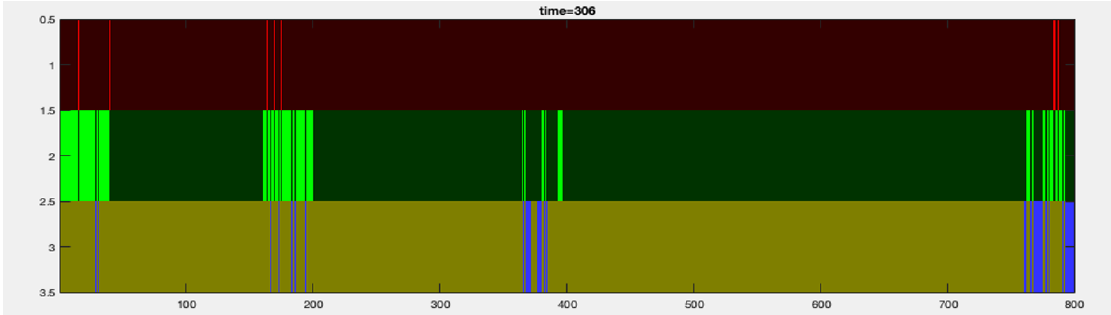
Figure 13. A snapshot of the status of the network. Bottom line denotes susceptible individuals (blue marks infected or recovered or died), middle lines are infected (light green marks), top line represents deaths (red marks). Fig. 13 and 14-left.